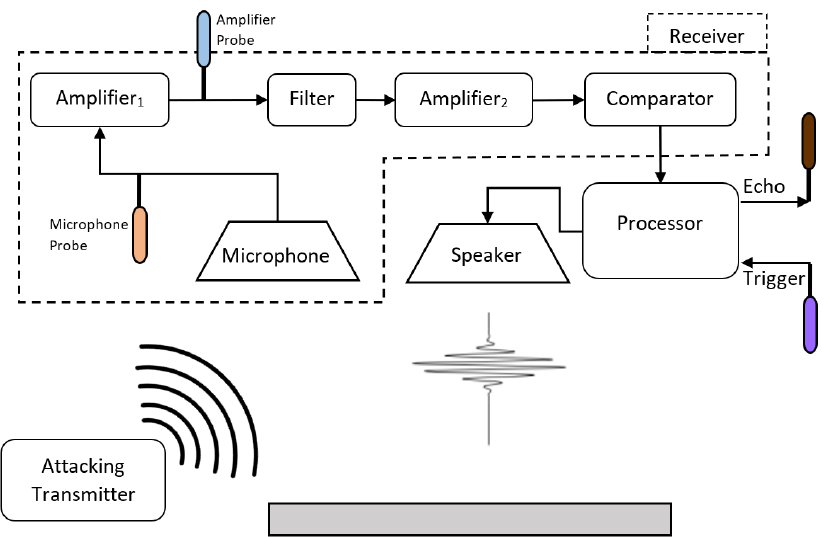
Figure 2. Sensor architecture and attack location.